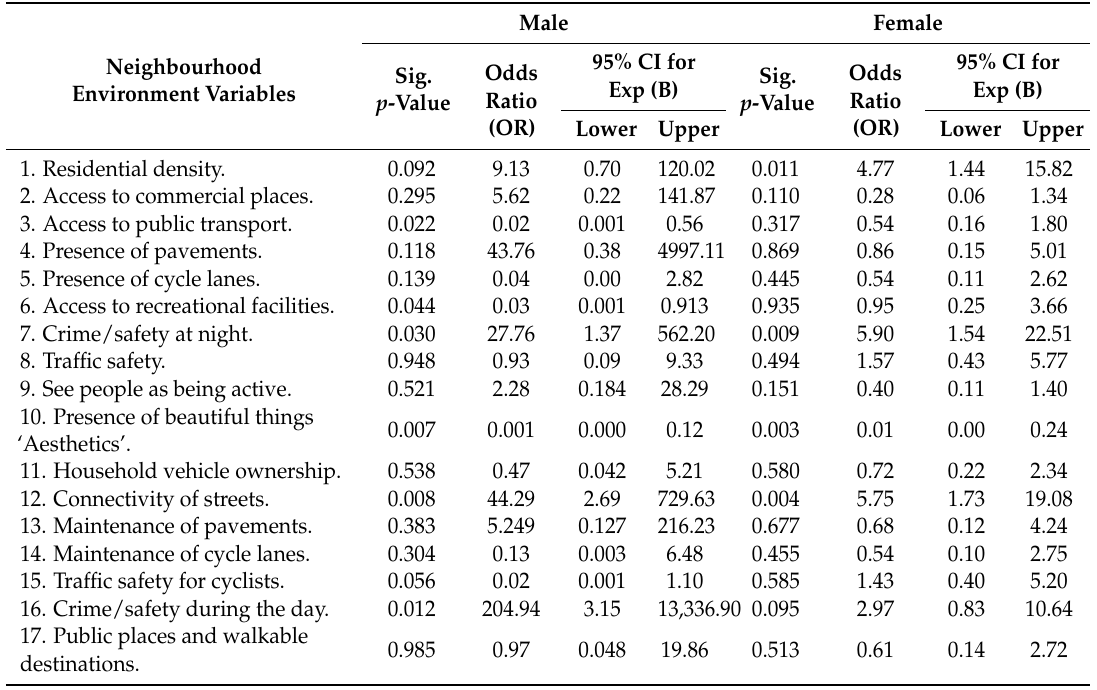
Table 4. Association between neighbourhood environment factors and BMI using binary logistic regression across gender-related variances when sociodemographic and SES factors were adjusted